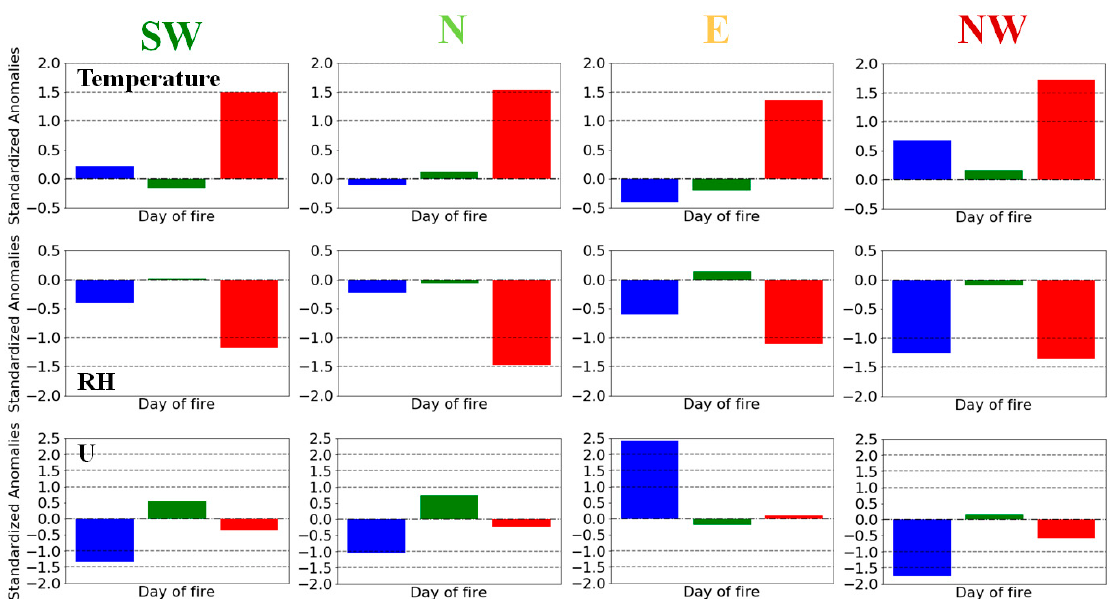
Figure 4. Composites of the standardized anomalies of the meteorological variables (temperature, relative humidity and zonal wind) of the fire day associated with the three Fire Weather Types, FWT_1 (blue), FWT_2 (green) and FWT_3